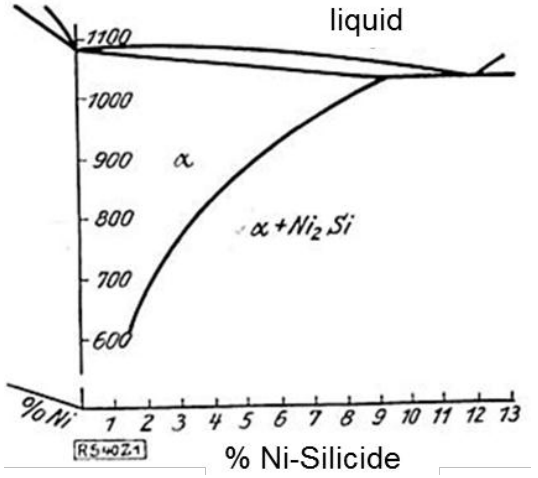
Figure 1. Pseudo-binary phase diagram of the Cu-Ni 2 Si-system after Corson, 1927